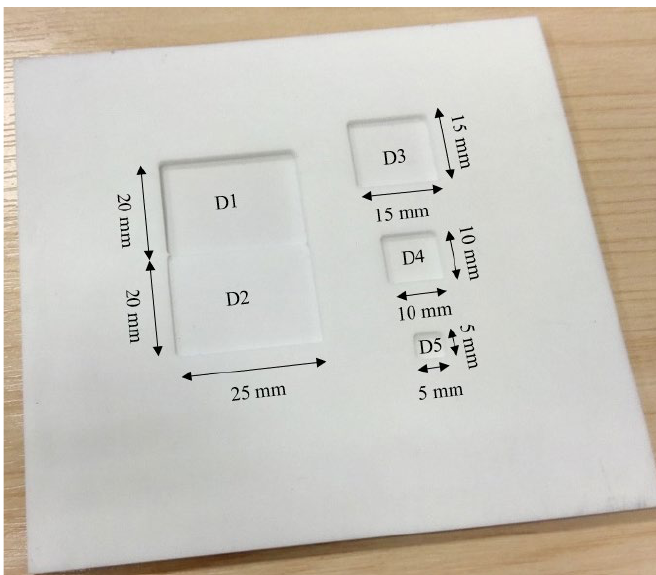
Figure 4. Raw data clustering of the k-medoids algorithm.